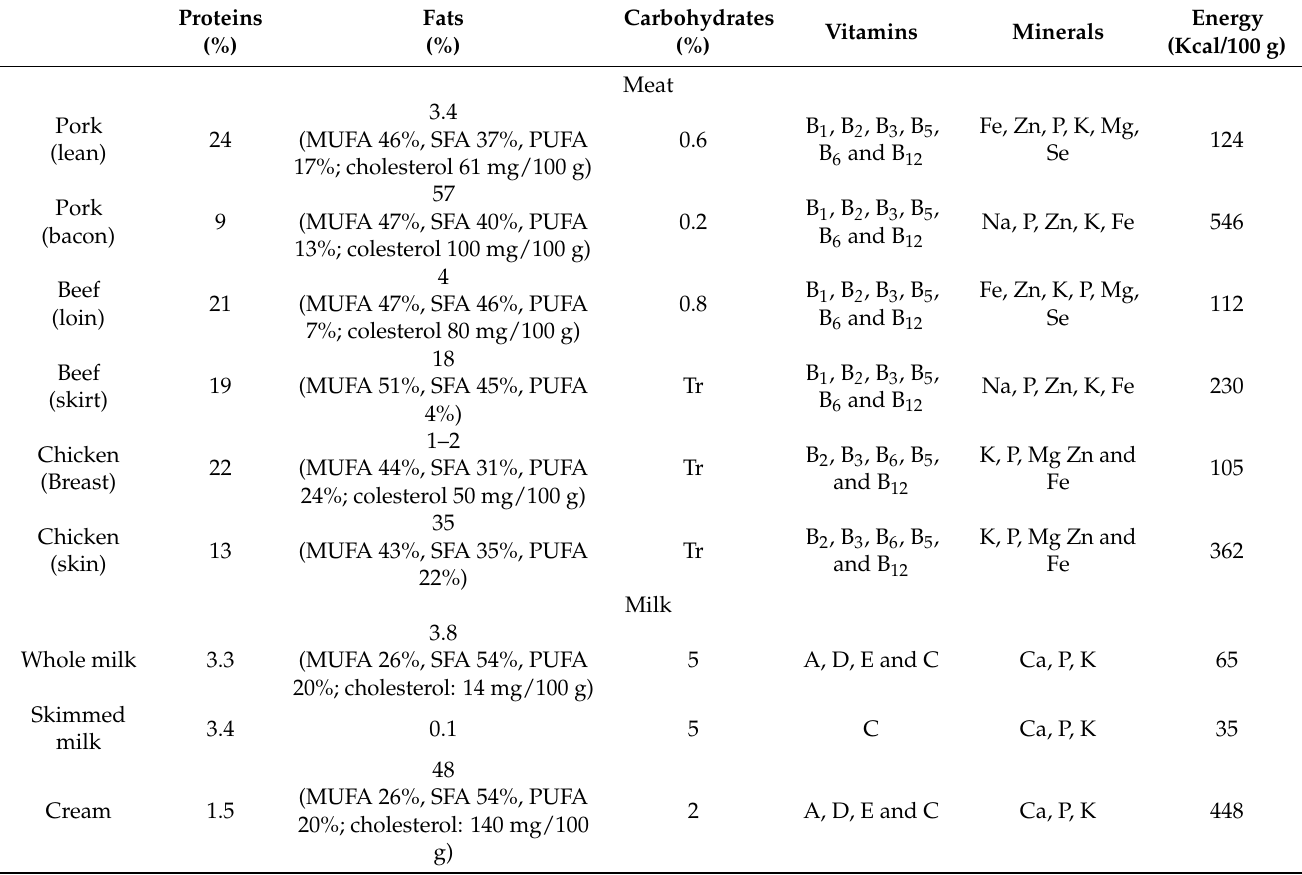
Table 2. Nutritional profile of some meats, milk, fish, seafoods and eggs